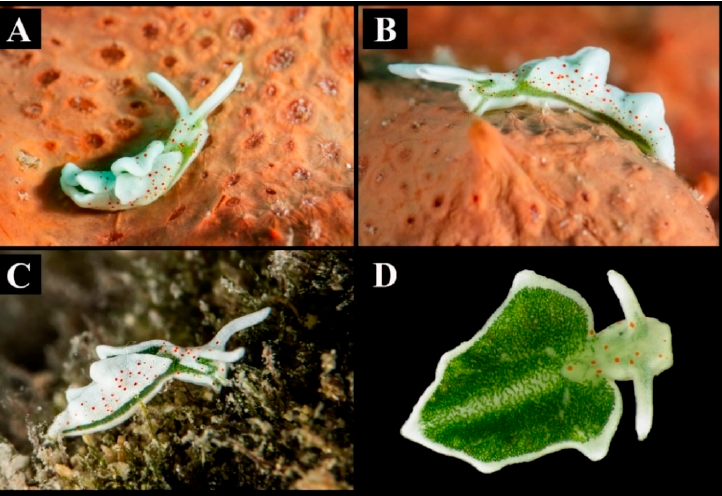
Figure 1. Elysia timida specimens. ( A ) Specimen crawling on an orange sponge in Lecce (Apulia, Ionian Sea, Central Mediterranean Sea). ( B ) Lateral view of the Apulian individual. ( C ) Elysia timida from Siracusa (Sicily, Tyrrhenian Sea, West Mediterranean Sea). ( D ) Dorsal view showing the photosynthetic region of the dorsum and of the internal portion of the